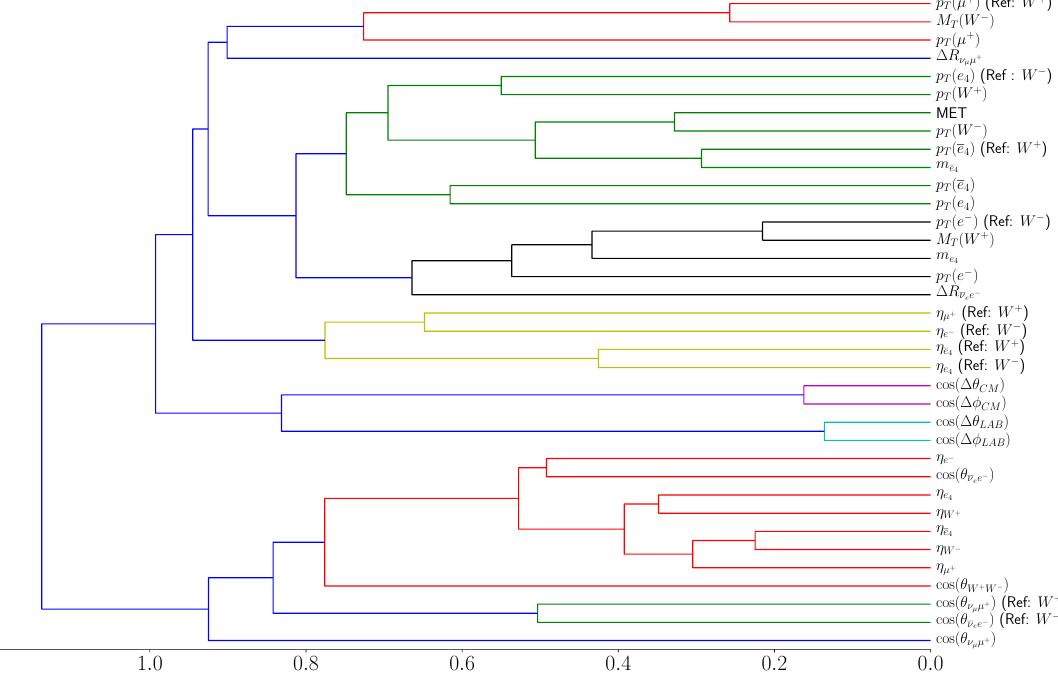
Figure 24. Hierarchical clustering of the various kinematic/angular variables utilized by the neural network model for a light VLL of 200 GeV and a ZA topology signal, under the Asimov metric. This dendrograms show how the NN groups the input features in different clusters. The dendrogram illustrates how each cluster is composed by drawing a U-shaped link between a non-singleton cluster and its children. The length of the two legs of the U-link represents the distance between the child